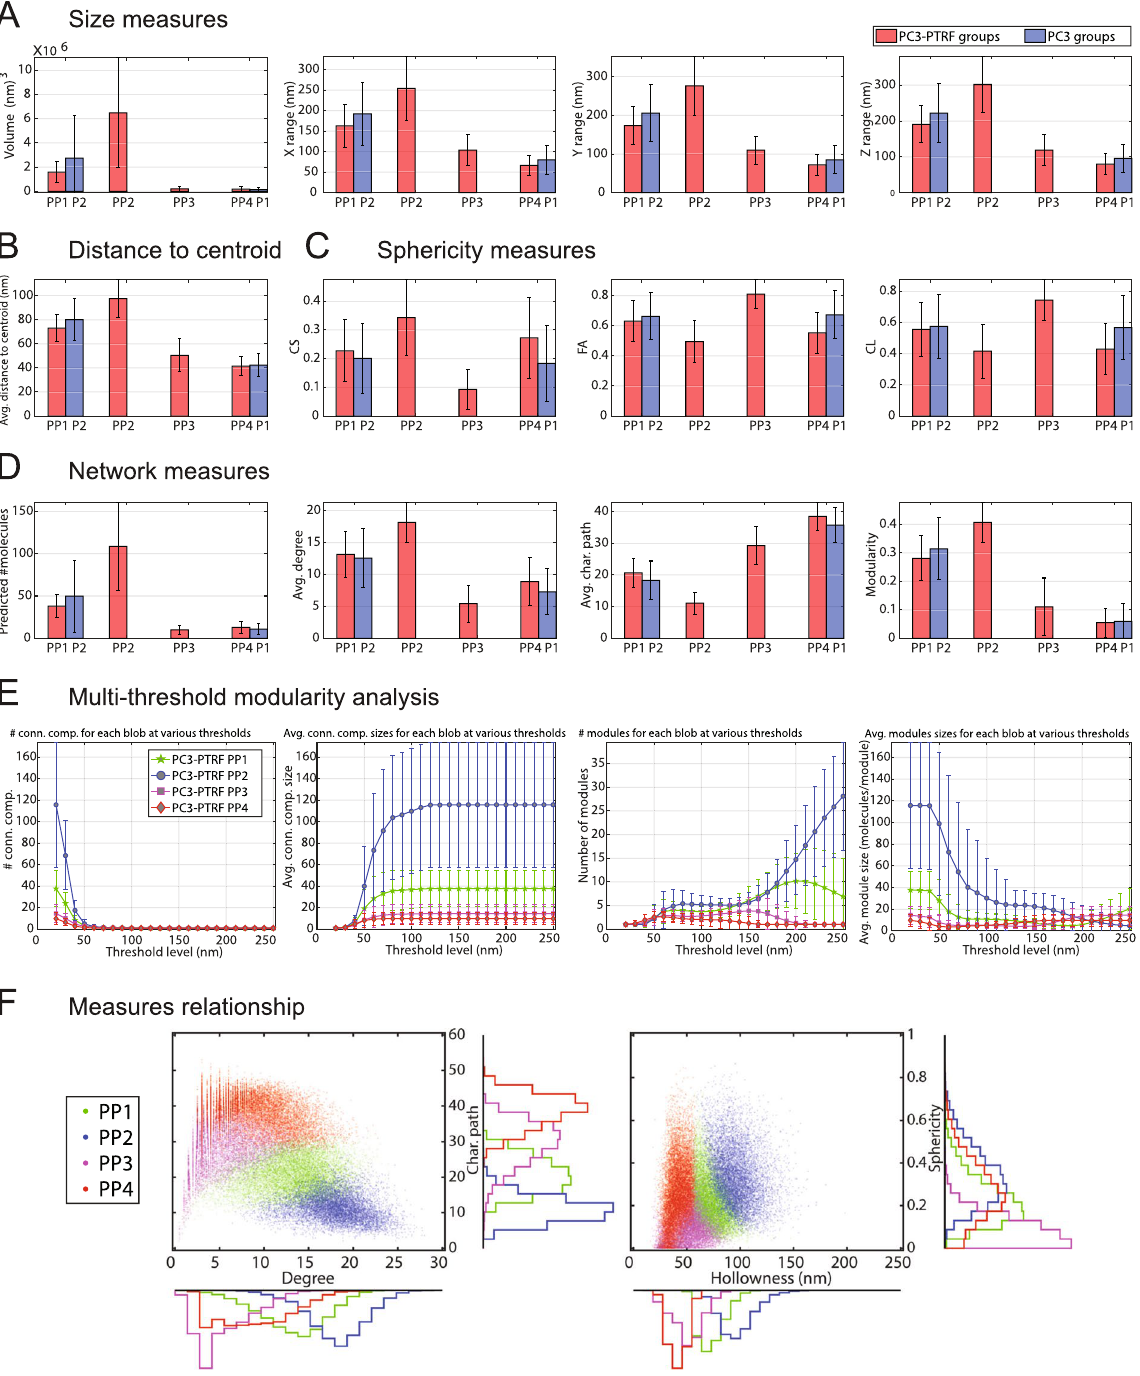
Figure 5. Digital bio-signatures of caveolae and scaffolds. Of 28 signatures, we present measures for each class of blob: ( A ) Size measures (volume, X-, Y-, Z-range); ( B ) Hollowness measure: (distance to centroid); ( C ) Shape measures (sphericity, fractional anisotropy, linearity); ( D ) Network measures (# predicted molecules, degree, character path, modularity). ( E ) Multi-threshold modularity analysis shows the number and average size of connected components and modules for PC3-PTRF blobs at different thresholds. ( F ) 2D relationship between features for different PC3-PTRF blobs are shown. The error bars represent the standard deviation. For ( A – D ), the differences for every pair of the groups are statistically significant (p <